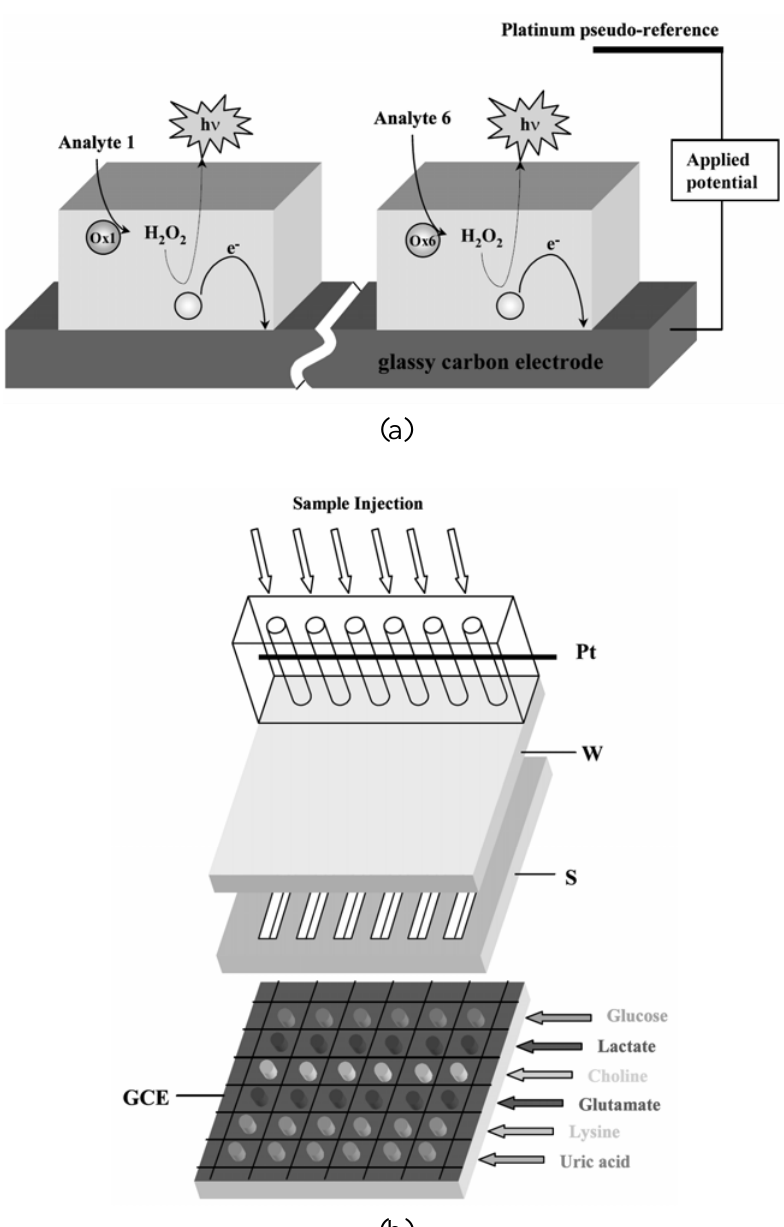
Figure 3. Schematic representation of the sensing layer organisation and reaction. (a) The Ox1 and Ox6 sphere represent the oxidase charged beads, the green sphere represents the luminol supporting beads. (b) Organisation of the ECL multifunctional bio-sensing chip. GCE: glassy carbon electrode, Pt: platinum pseudo-reference electrode, S: silicone spacer, W: plexiglas window